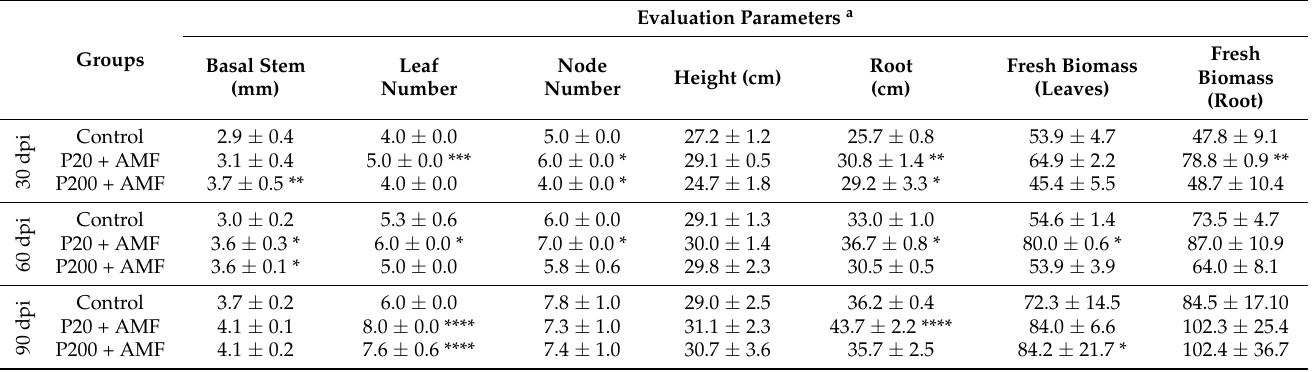
Table 3. Growth parameters of Piper divaricatum inoculated with AMF at different P